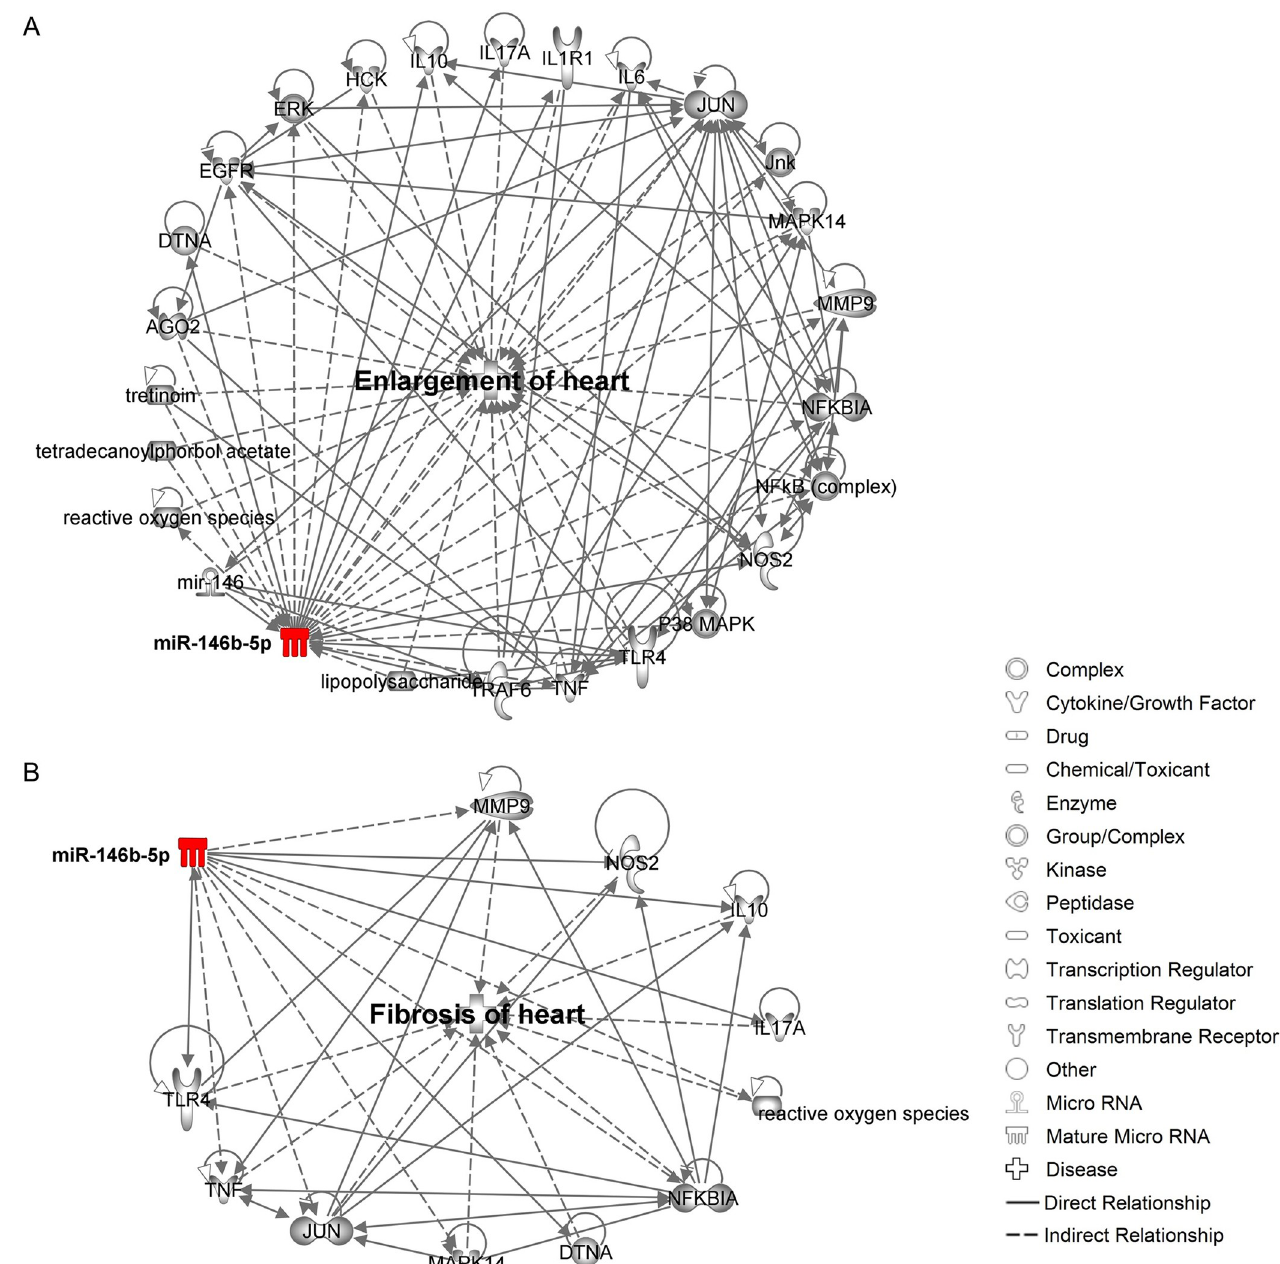
Fig 7. Target prediction analysis for Bz-treated group. (A) Enlargement of heart pathway. (B) Fibrosis of heart pathway. The red color indicates miRNA upregulation. Full lines indicate a direct relationship, while dashed lines indicate an indirect relationship.